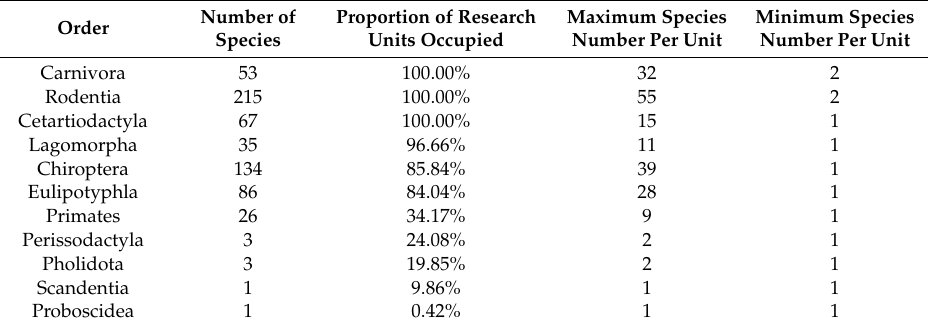
Table 1. Taxonomic distribution of China’s 624 of terrestrial mammal